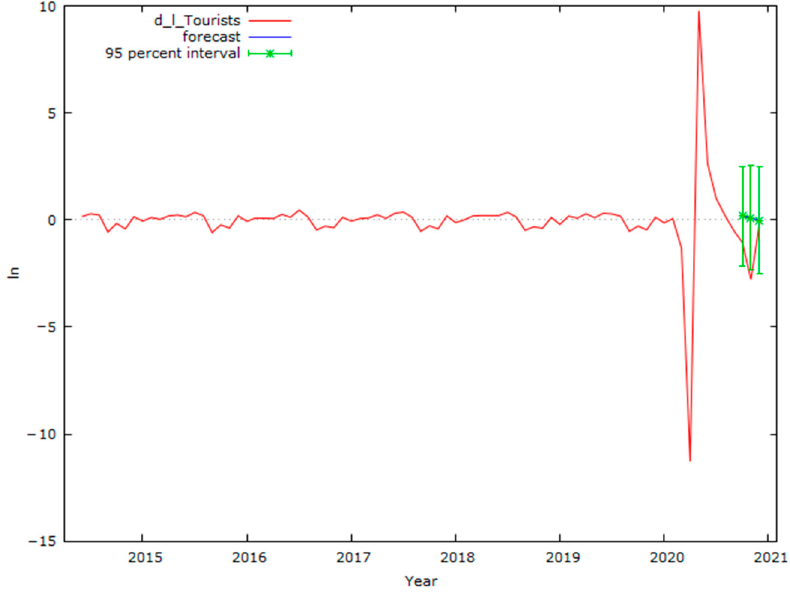
Figure 5. Forecast for tourist arrivals from October 2020 to December 2021. Sources: authors compilation based on Table 2.